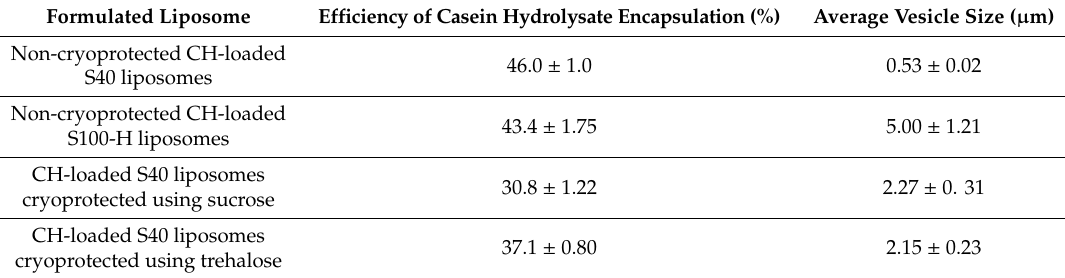
Table 1. Comparison of particle size and casein hydrolysate (CH) entrapment e ffi ciencies of the tested liposome formulations as reported by Yokota et al.